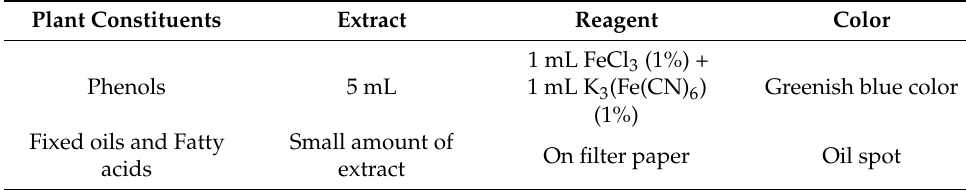
Table 4. Cont. Plant